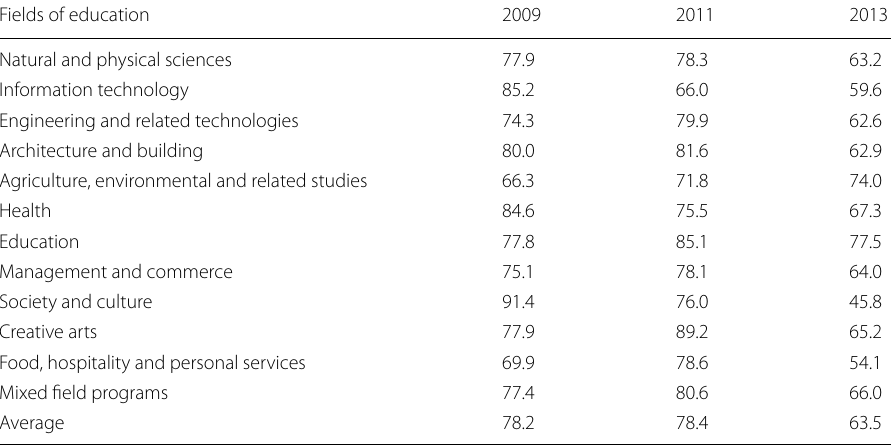
Source: NCVER (2019), own